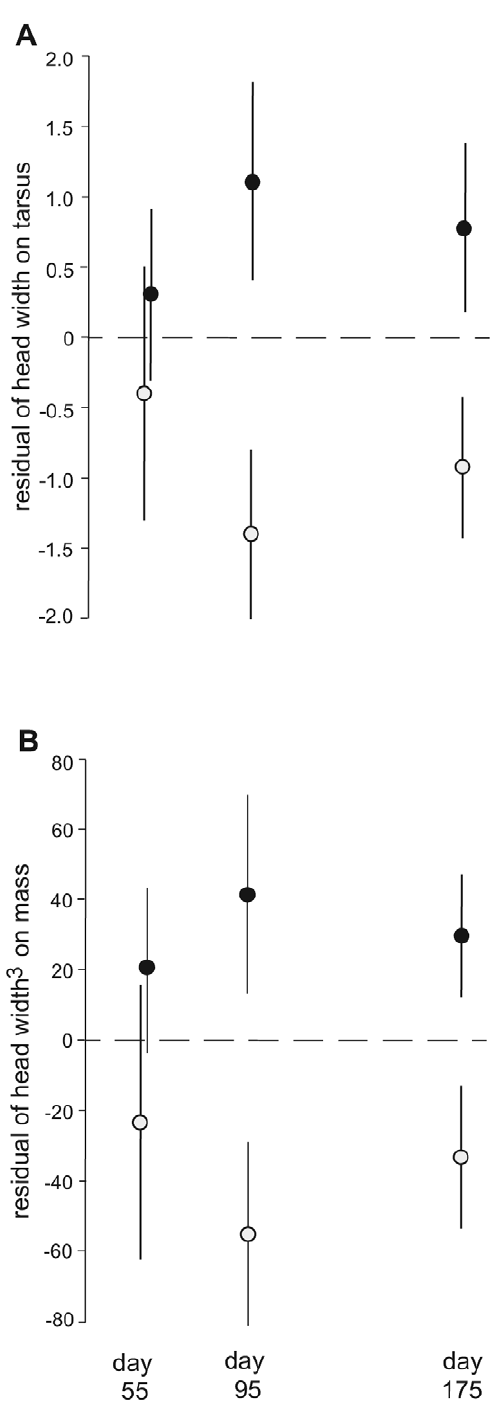
Figure 1. Relative head widths (mean ± S.E.) of birds reared on HI vs LO diets. A: residuals of head width on tarsus; B: residuals of head width 3 on mass. White circles – LO diet birds; black circles – HI diet birds. (See also Table 2.)